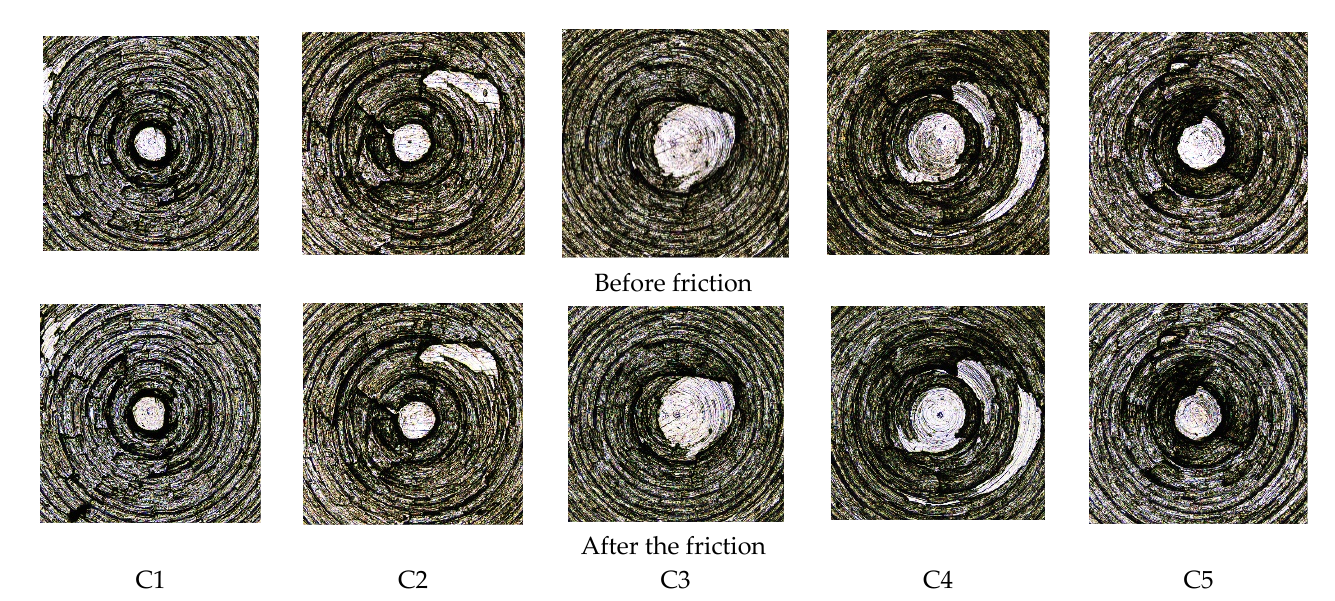
Figure 10. Surface morphology of the metal grinding head before and after friction.